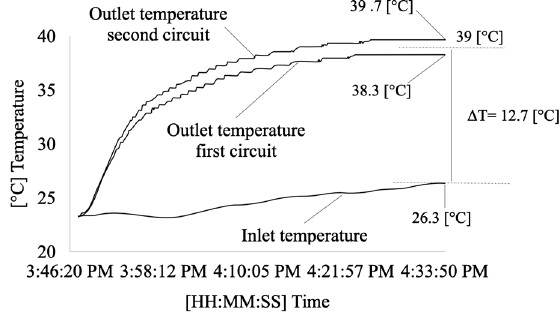
FIG. 20. Inlet and outlets water temperature versus time during heating phase at 84 kW.